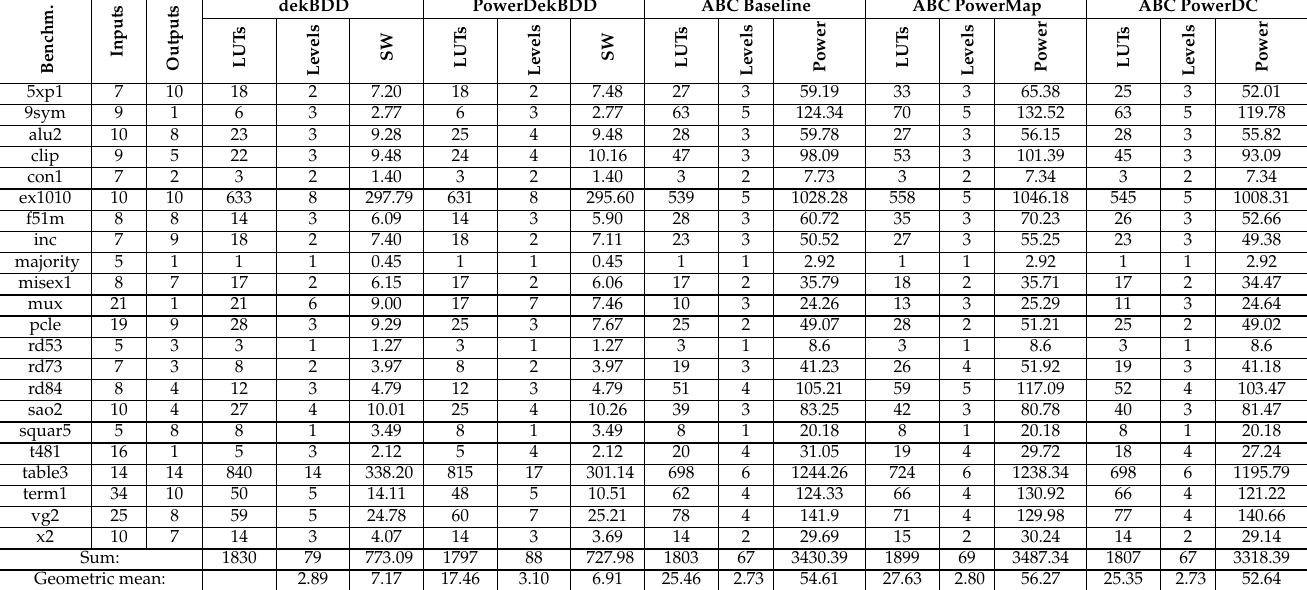
Table 1. Comparison of academic synthesis